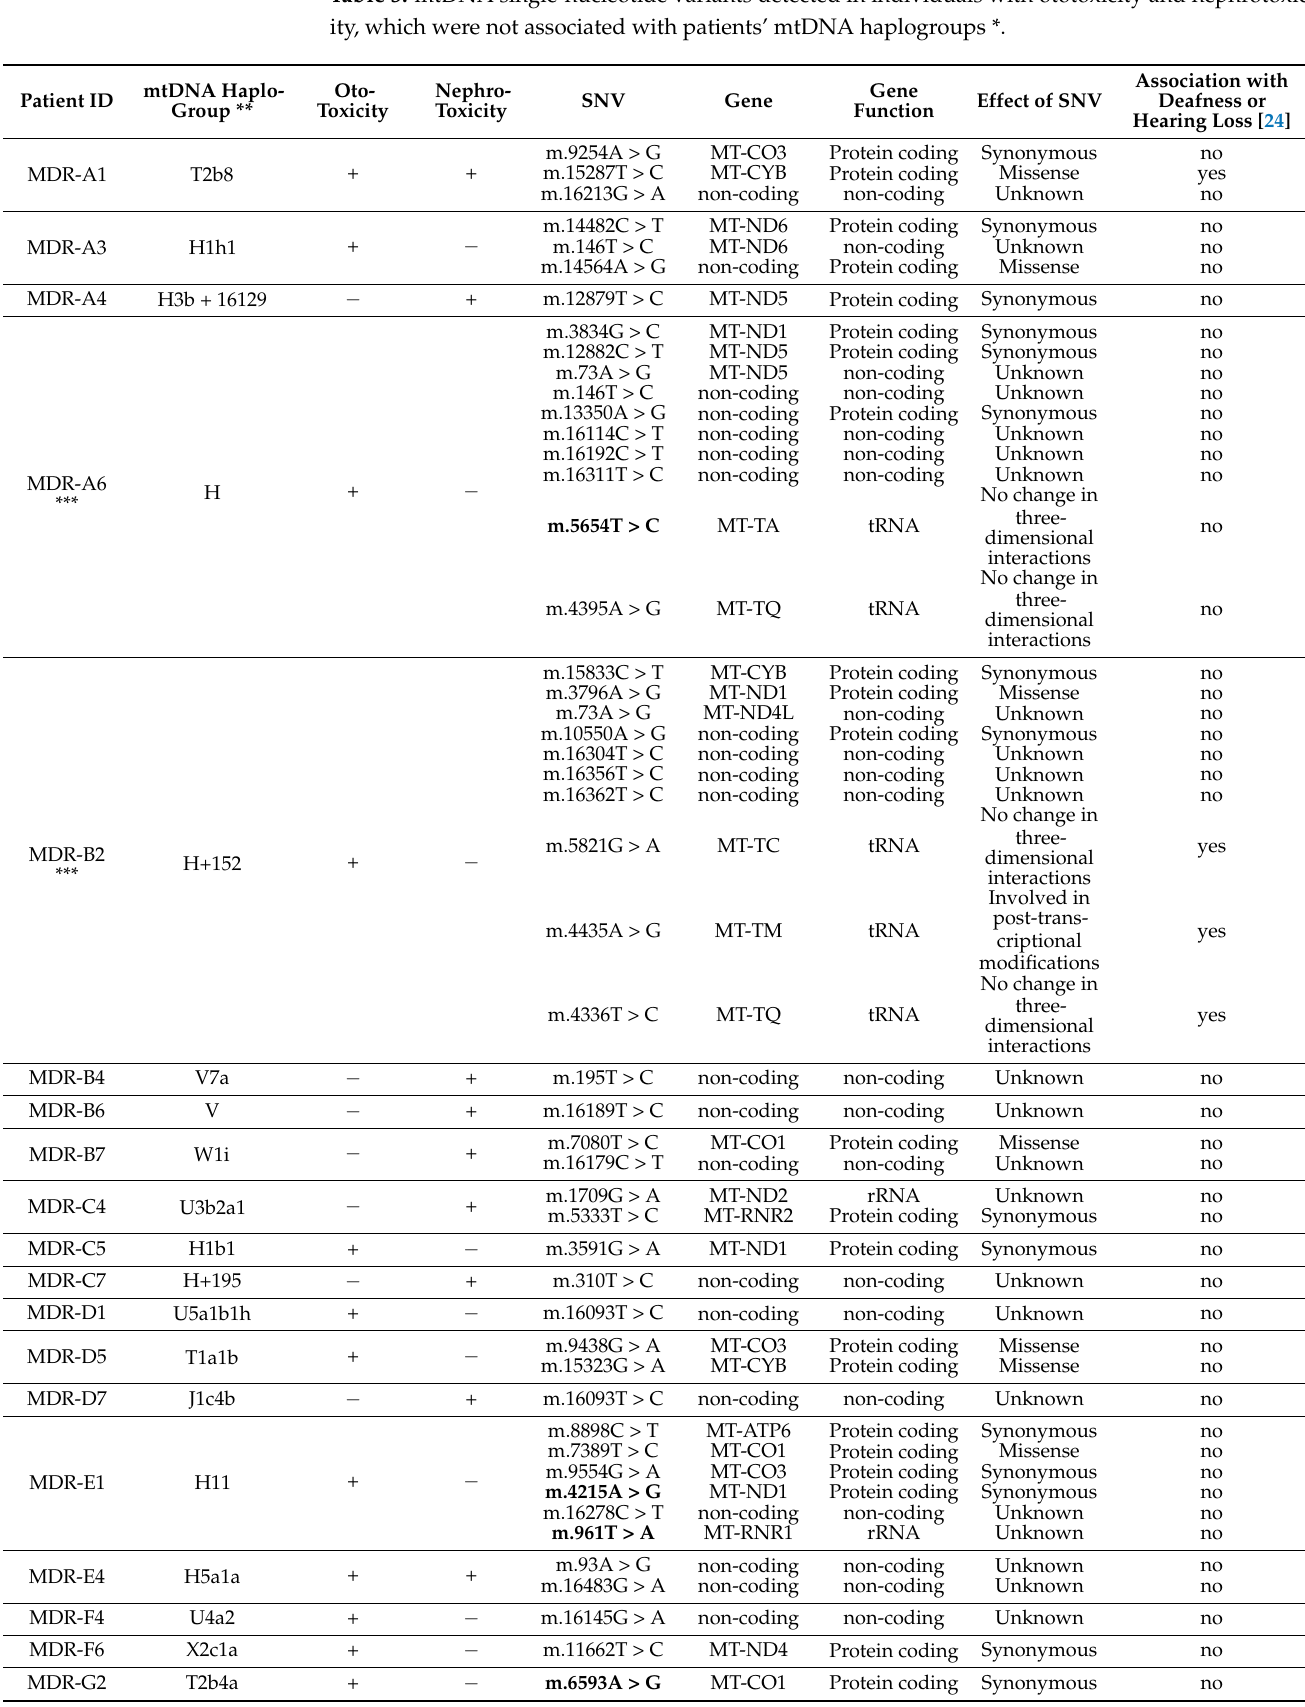
Table 3. mtDNA single-nucleotide variants detected in individuals with ototoxicity and nephrotoxic- ity, which were not associated with patients’ mtDNA haplogroups